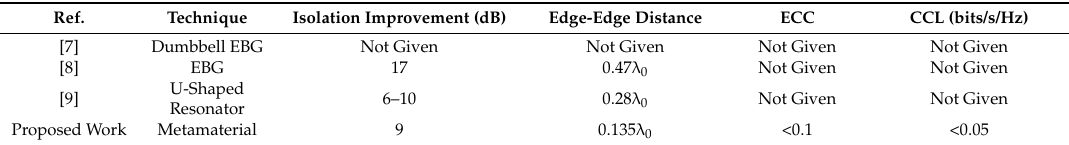
Table 3. Performance comparison with previously published